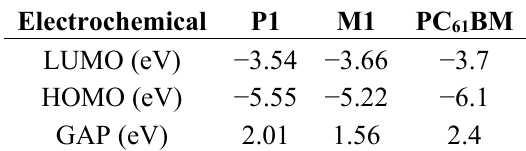
Figure 4. Schematic representation of HOMO and LUMO levels for mixtures: ( a ) P1:PC 61 BM (1:2 by weight) and ( b ) P1:PC 61 BM:M1 (1:2:1 by weight). Table 3. Electrochemical HOMO and LUMO levels and GAP of P1, M1 and PC 61